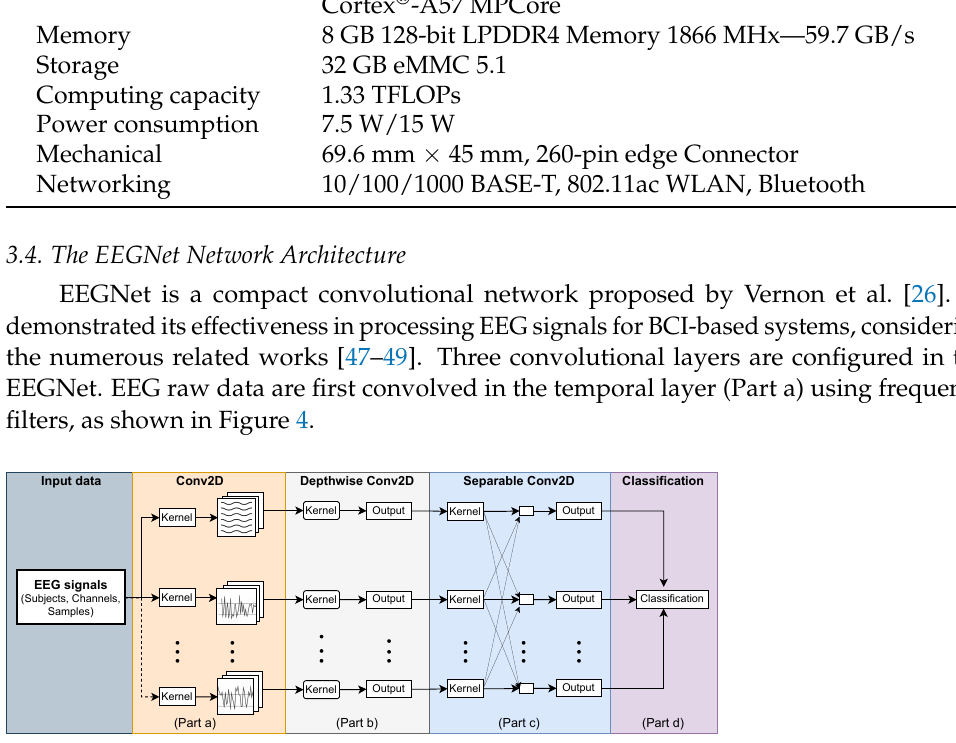
Figure 4. The encapsulated EEGNet structure. EEG signals were organized by subject, channel, and sample length. This data matrix was expanded to four dimensions fulfilling the EEGNet input matrix dimension. In Part (a), temporal features are extracted by Conv2D, and in Part (b), spatial filters are applied to enhance feature maps. Then, feature maps are combined in Separable Conv2D (Part (c)), providing the output class probability (Part